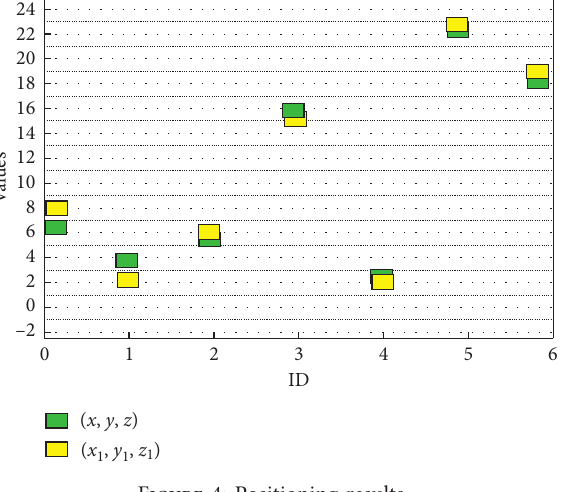
Figure 4: Positioning results.